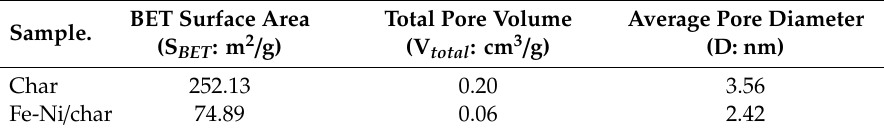
Table 2. Textural properties of fresh char and char-supported catalysts.